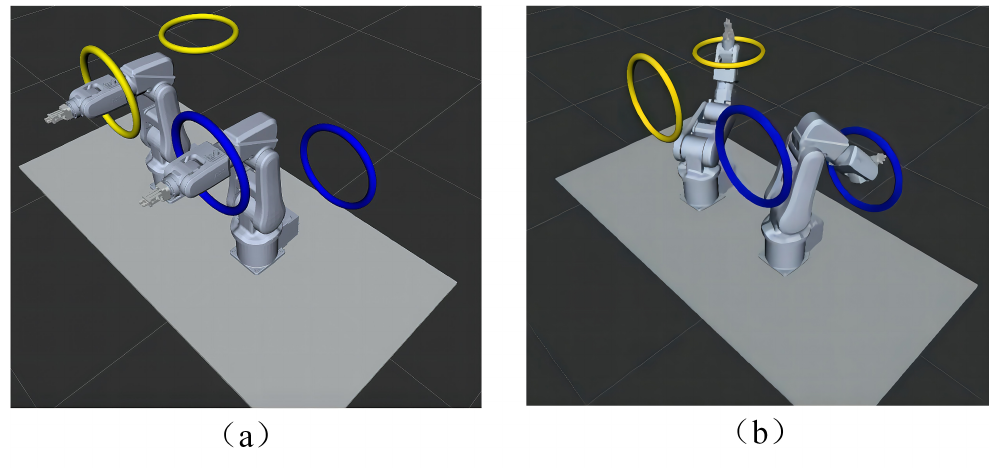
Figure 7. Experimental scenario 1. ( a ) Motion start state. ( b ) Motion end